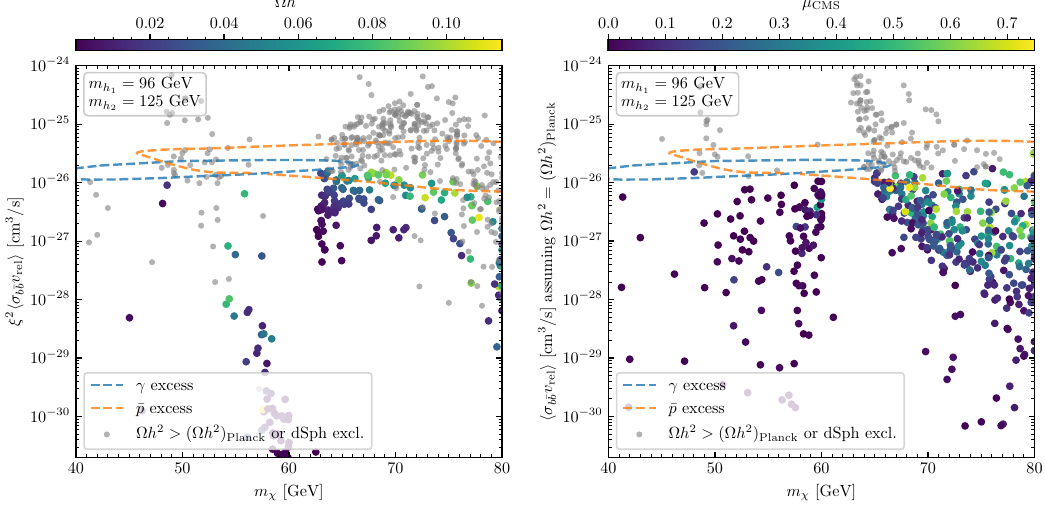
Figure 8 . Today’s velocity averaged annihilation cross section of χ into pairs of b quarks taking into account the number density as predicted by thermal freeze-out (left) and assuming Ω h 2 = 0 . 119 (right). The colour coding indicates the predicted value of Ω h 2 (left) and the value of m h Also indicated are the regions in which the cosmic-rays excesses could be explained (blue and orange dashed lines) [54, 66]. Grey points are excluded by Ω h 2 > (Ω h 2 measurements (left and